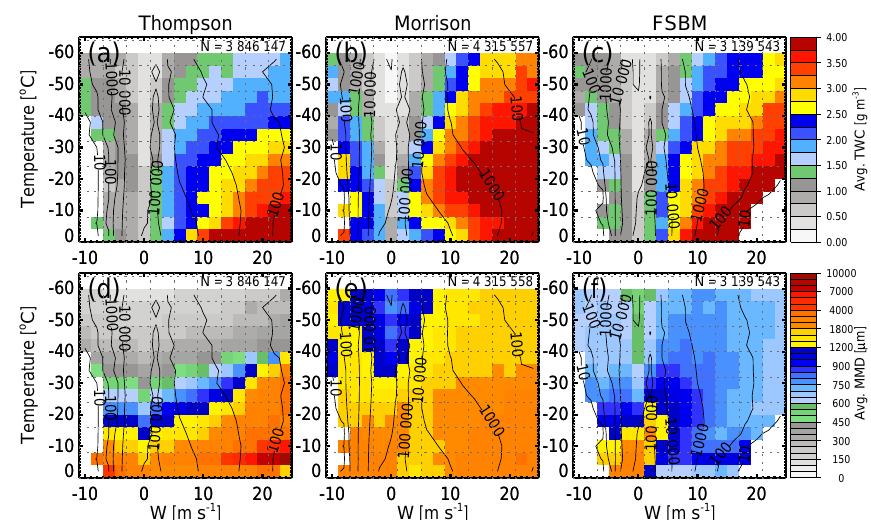
Figure 11. Joint histograms of w and temperature below freezing using bins sizes of 2ms − 1 for w and 4 ◦ C for temperature. Color fill is average TWC for (a) – (c) and average combined-hydrometeor MMD for (d) – (f) . The Thompson scheme is shown in (a) and (d) , the Morrison scheme in (b) and (e) , and the FSBM scheme in (c) and (f) . Sample sizes are shown in the upper-right corner and order of magnitude sample sizes are contoured in